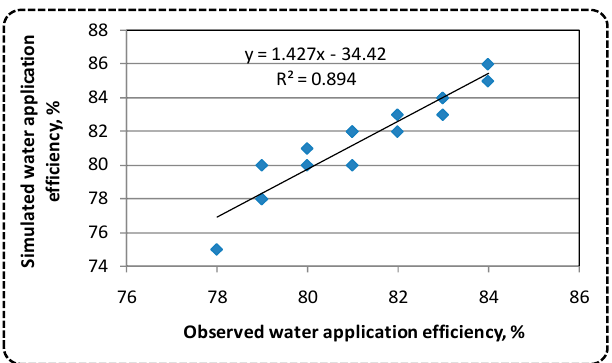
Figure 8. Observed versus simulated water application efficiency for all treatments for bothseasons.